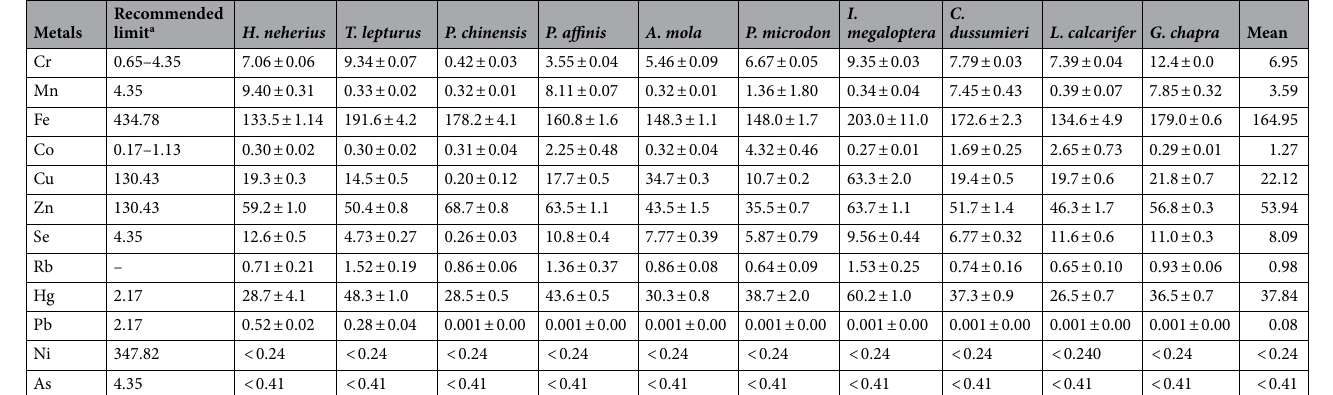
Table 5. Concentrations (mg/kg dw) of the determined metals in dried fish collected from Cox’s Bazar. Results are reported as the mean ± SD from triplicate analysis. Concentrations of As and Ni in all analyzed dried fish samples were too low to detect by the adopted EDXRF analytical system. The values quoted herein are the minimum detectable limit (MDL) for these two elements. a Limits from WHO/FAO/MHSAC (Murtala et al. 51 ; Ahmed et al. 49 ; Alipour et al. 59